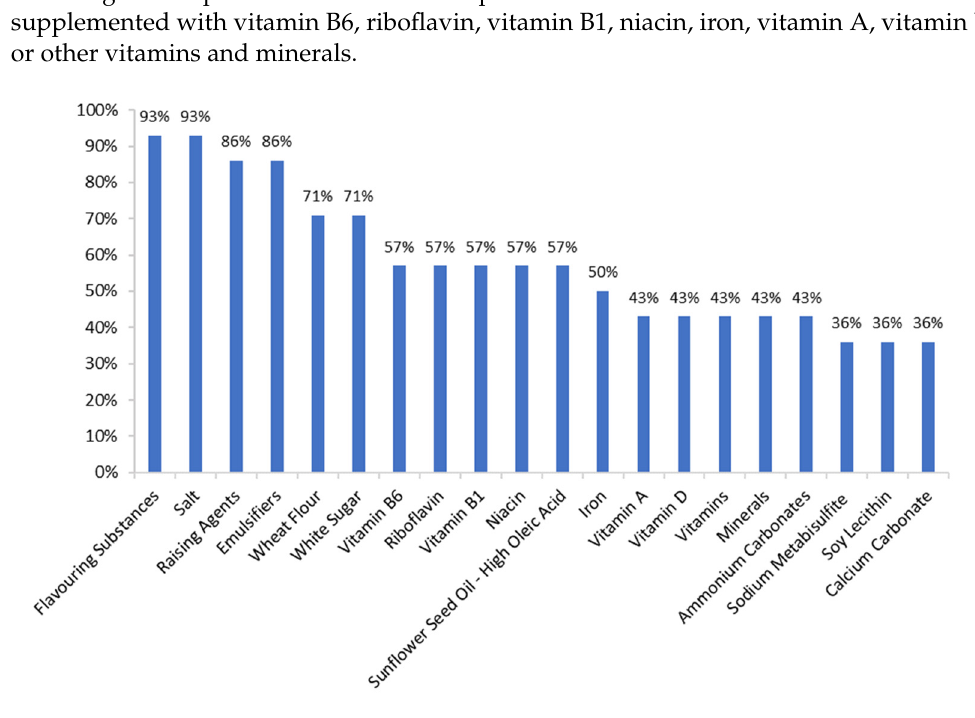
Figure 4. Top 20 (Food) ingredients declared in 49 plain biscuits targeted at children aged 5–13 years, sold in Spain between 2017 and 2022. Data found in Mintel GNPD Database (October 2022).